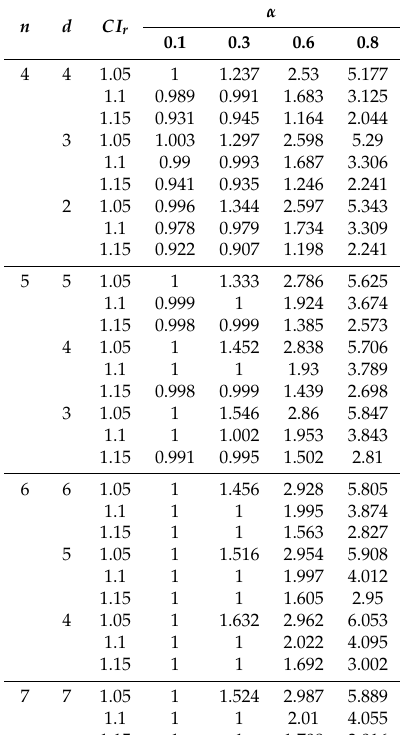
Table 2. Average iterations values in Algorithm